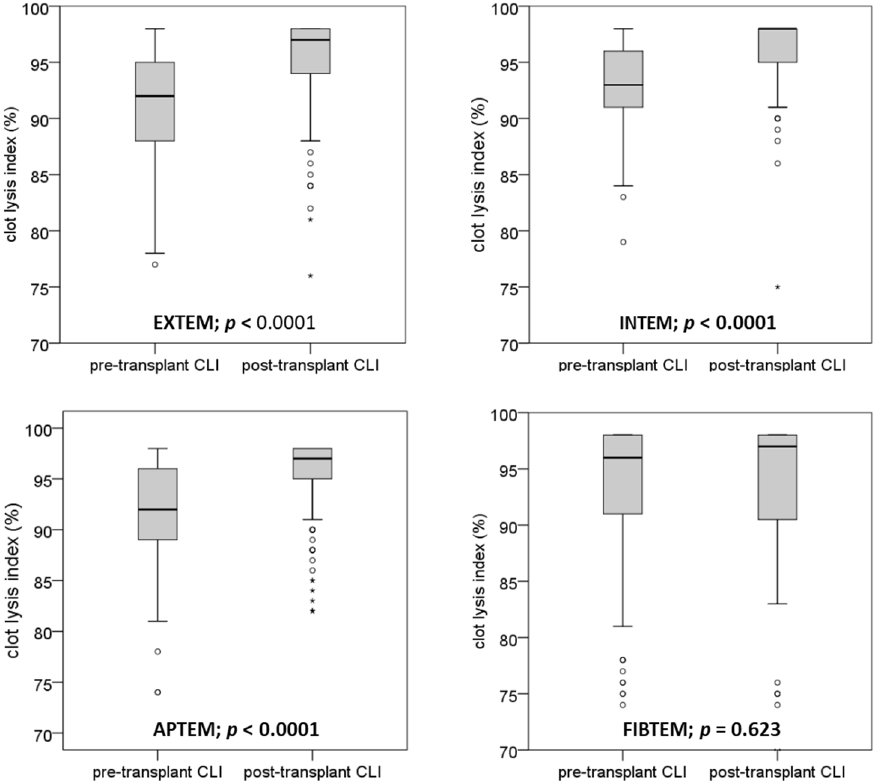
Figure 3. Boxplots depicting the median and quartiles of clot lysis index values obtained at the beginning and the end of liver transplantation. ROTEM™ tests were performed with extrinsic and intrinsic system activation (EXTEM, INTEM), as well as in presence and absence of a fibrinolysis inhibitor (APTEM) and a platelet clot retraction inhibitor (FIBTEM), respectively. The Wilcoxon test was used for statistical evaluation. Outliers are indicated by circles an asterisks.